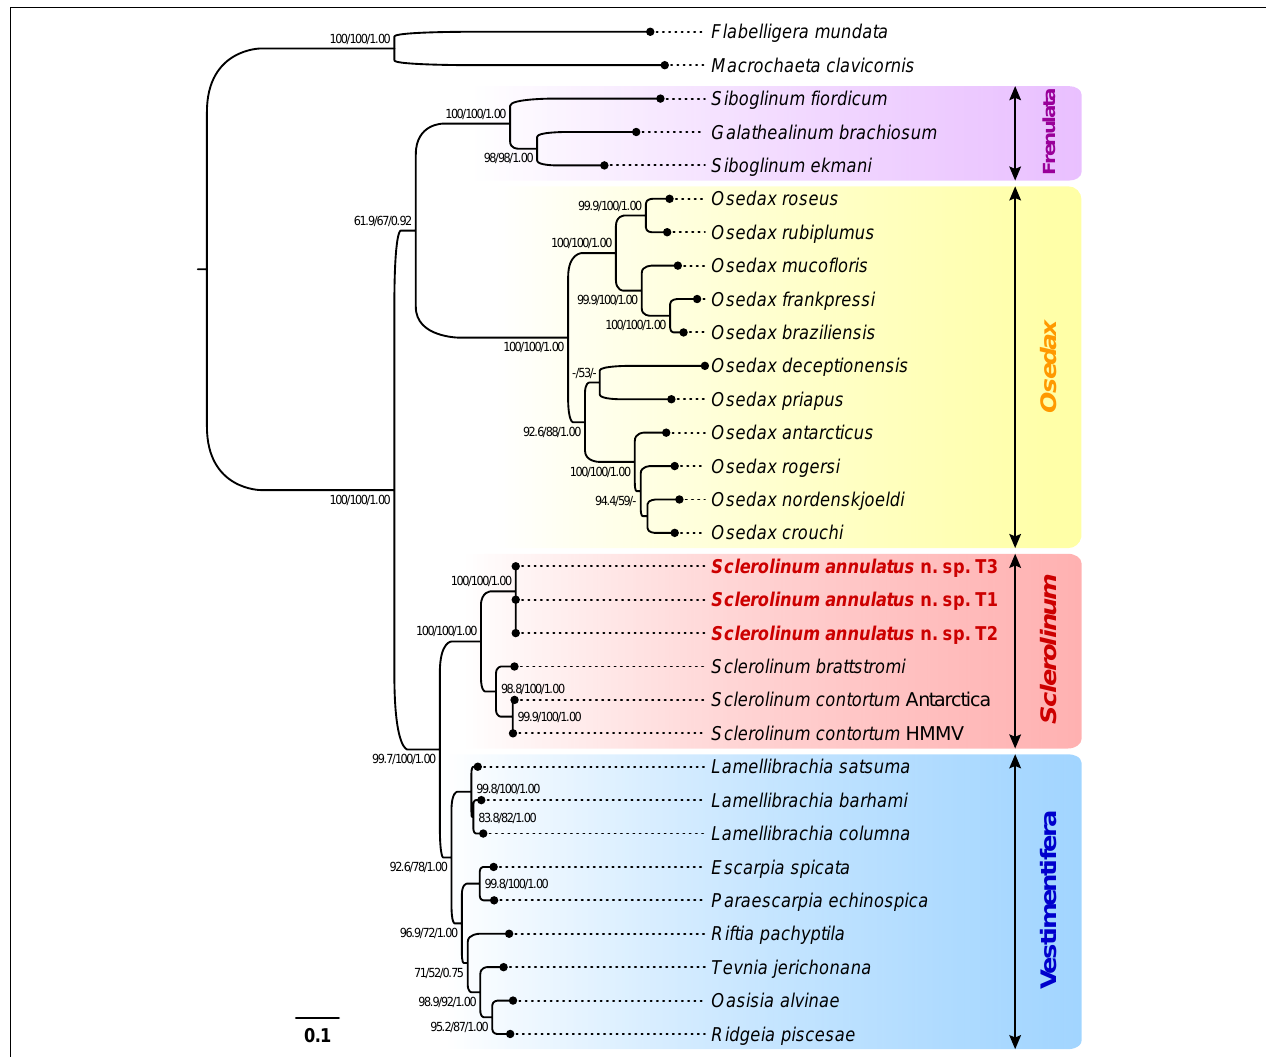
FIGURE 8 | A phylogenetic tree of siboglinid tubeworms based on the maximum-likelihood (ML) topology inferred from a 3,478-bp concatenated alignment of the cox1 (1,211 bp with gaps), 16S rRNA (532 bp with gaps), and 18S rRNA (1,735 bp with gaps) genes. Bootstrap values from the Shimodaira-Hasegawa-like (SH-like) approximate likelihood ratio tests and the standard non-parametric bootstraps (NB) of the ML analysis, as well as the posterior probabilities from the Bayesian inference (BI) analysis, are shown at nodes (ML-SH/ML-NB/BI). Dashes (-) indicate bootstrap values < 50 or posterior probabilities < 0.70. Scale bar: the number of substitutions per site. HMMV, Haakon Mosby Mud